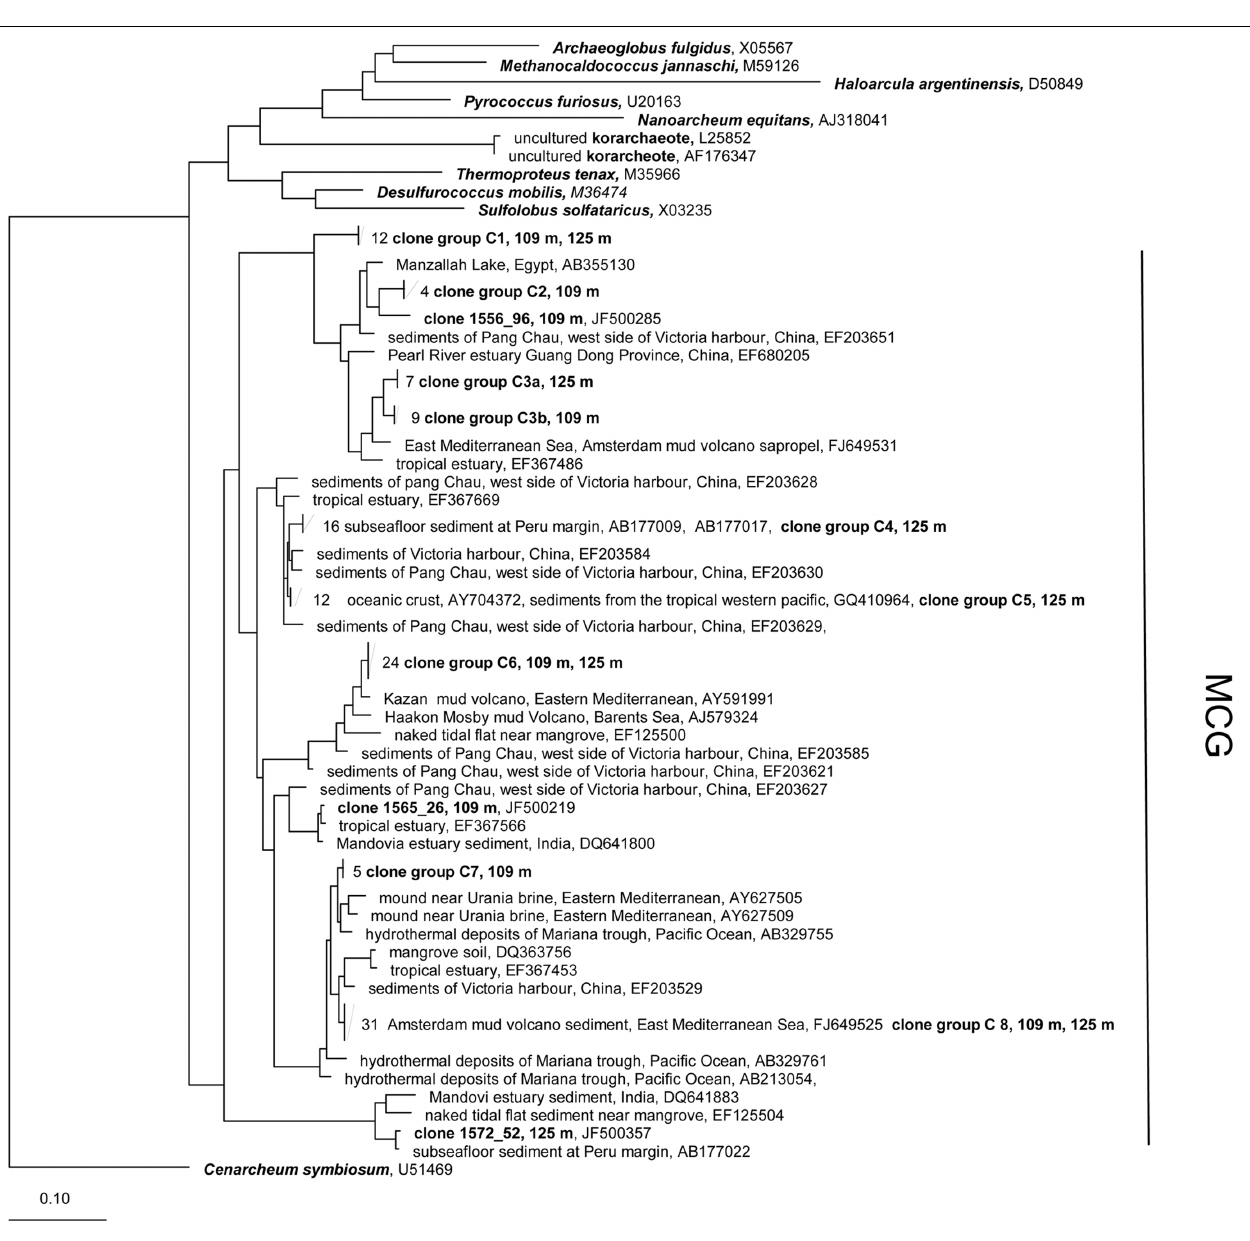
FIGURE 7 | Maximum-Likelihood phylogenetic tree of the Crenarcheota showing clades found in terrestrial CBIS post-impact sediment. The tree